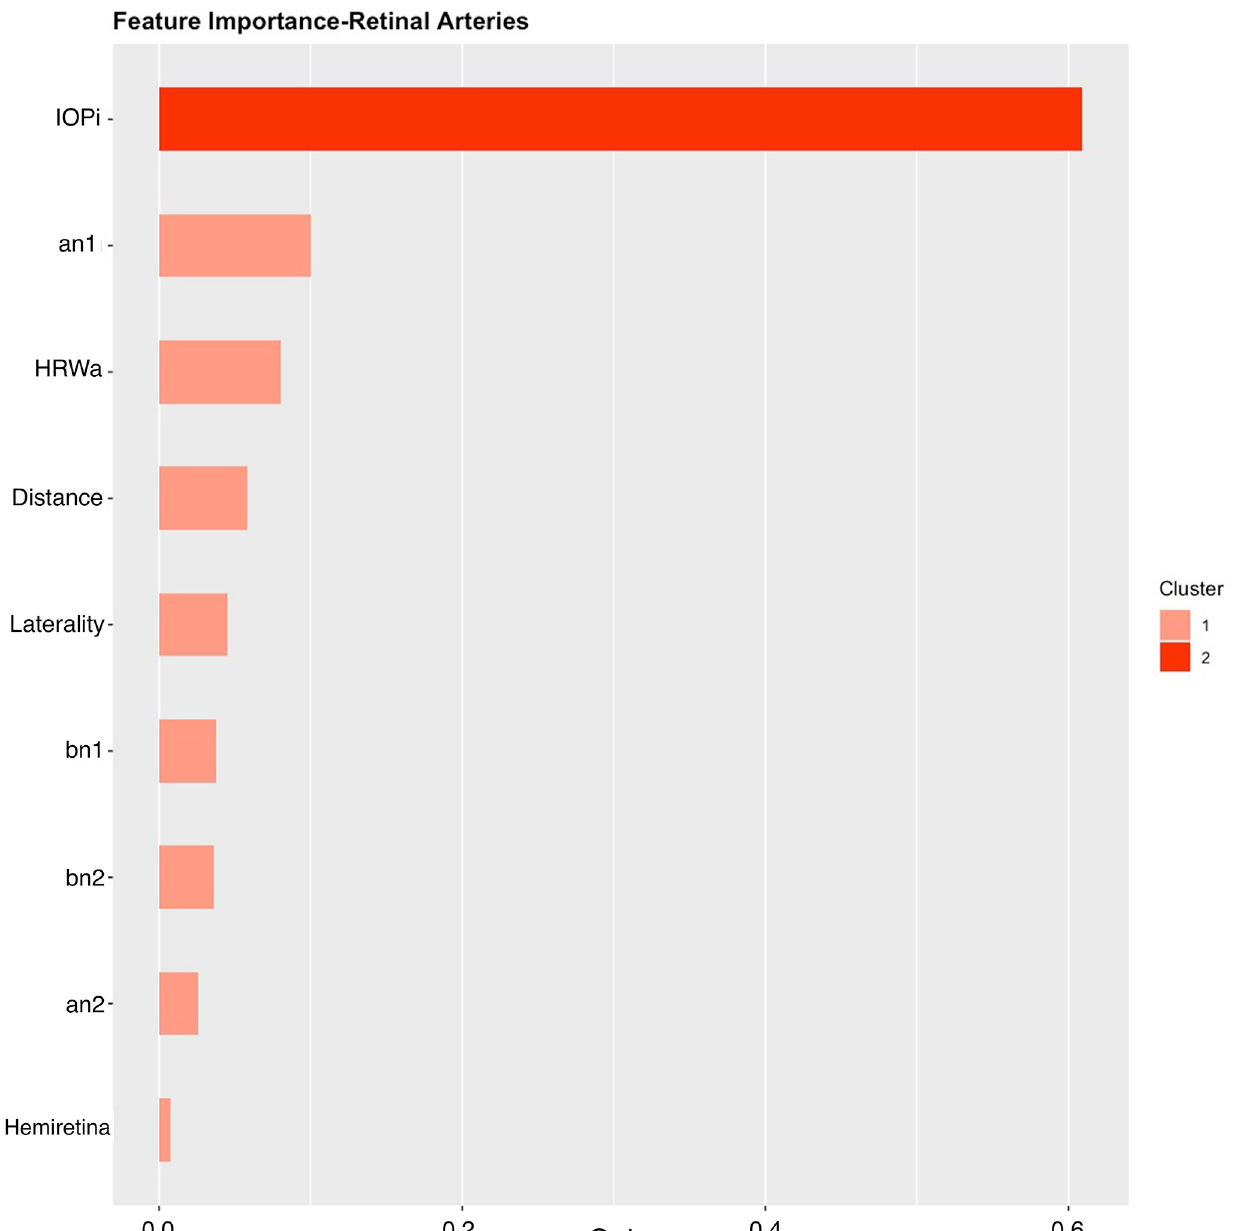
Fig 7. Importance plot retinal arterial model. IOP i , a n1 and HRW a were the most important features in this model. IOP i = Induced intraocular pressure, HRW a =Harmonic regression wave amplitude, a n1,2 = the cosine coefficient of the first and second harmonics, b n1,2 = the sine coefficient of the first and second harmonics, laterality = left / right eye, Distance = distance along the retinal vessel measured in mm, hemiretina = superior / inferior retina.